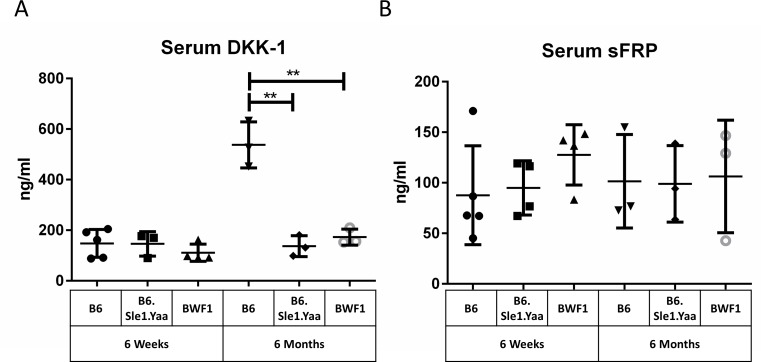
Serum DKK-1 is suppressed in lupus-prone mice over time.Sera from young (6 week) and aged (6 month) B6 healthy control, B6.Sle1.Yaa lupus-prone, and BWF1 lupus-prone mice were collected and assayed by ELISA for DKK-1 and sFRP. (A) DKK-1, an inhibitor under transcriptional control of Wnt/β-catenin, did not rise over time in lupus-prone mice. (B) Serum sFRP, which by contrast is an epithelial cell-restricted Wnt/β-catenin transcription target, showed no such changes.